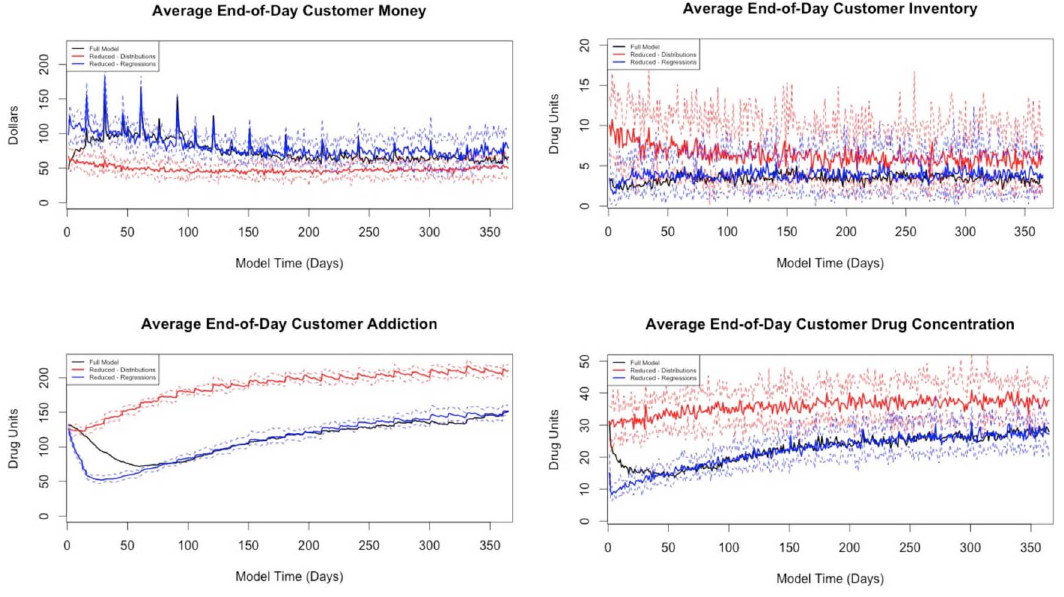
Figure 8. Comparison of full and reduced models. Dotted lines represent 95% intervals for reduced model output.